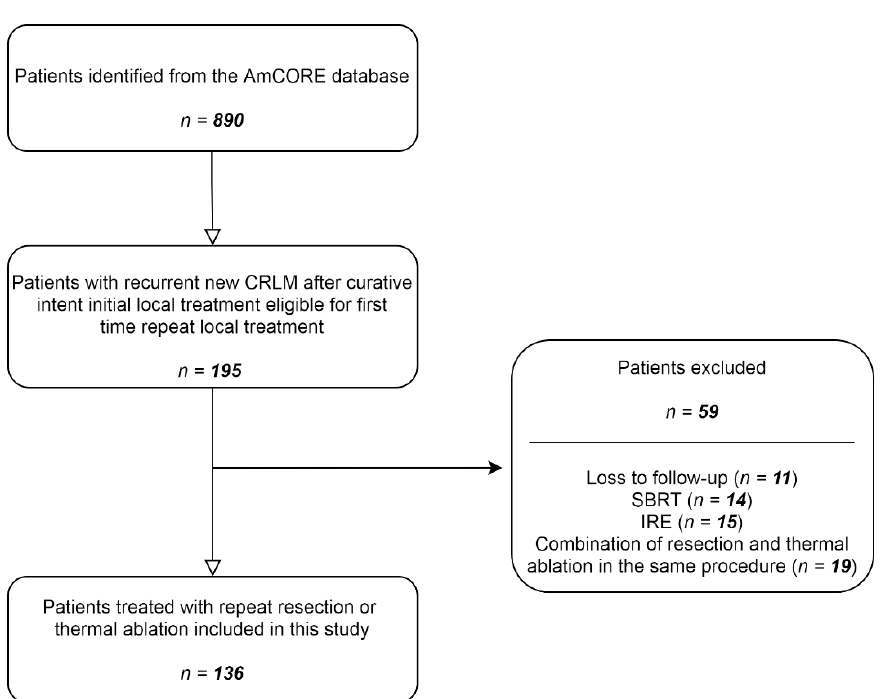
Figure 1. Flowchart of included and excluded patients.